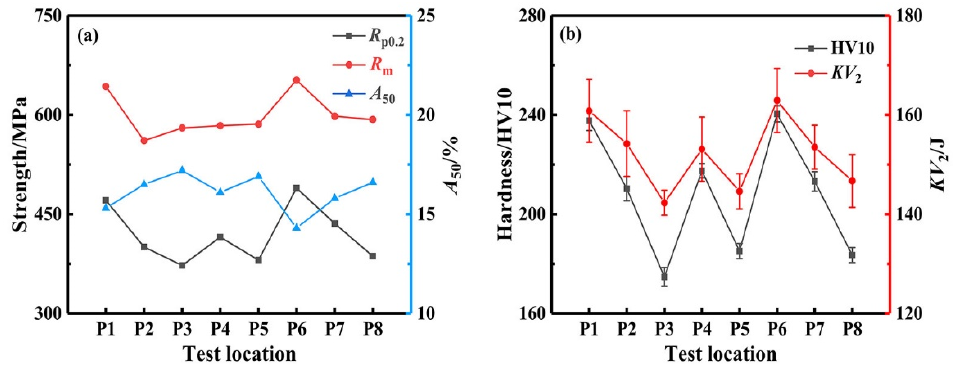
Figure 9. Mechanical properties at the different temperature measurement points. ( a ) Strength and elongation, ( b ) hardness and impact energy.